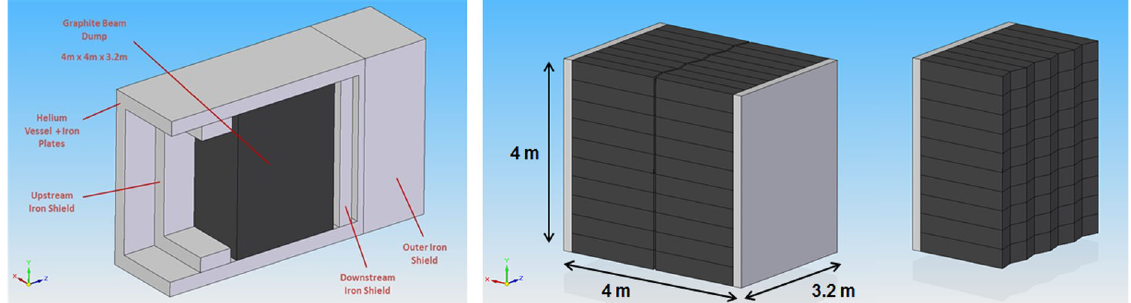
FIG. 14. Components of the beam dump (left) and graphite blocks